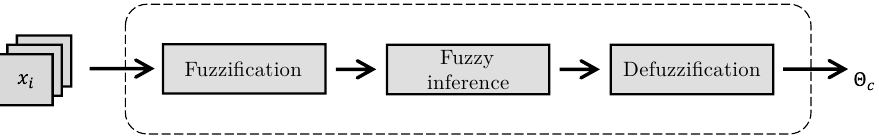
Figure 4. Fuzzy logic based data quality fusion. Consisting of the steps fuzzification, fuzzy inference and